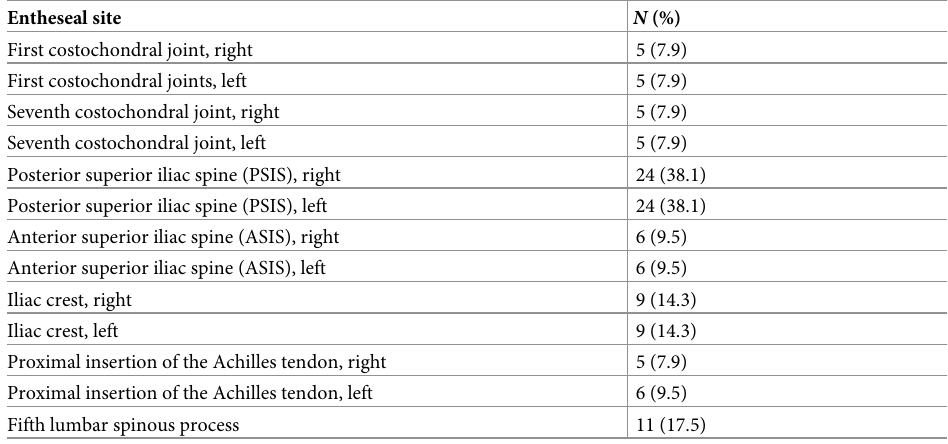
Proximal insertion of the Achilles tendon, right Proximal insertion of the Achilles tendon, left